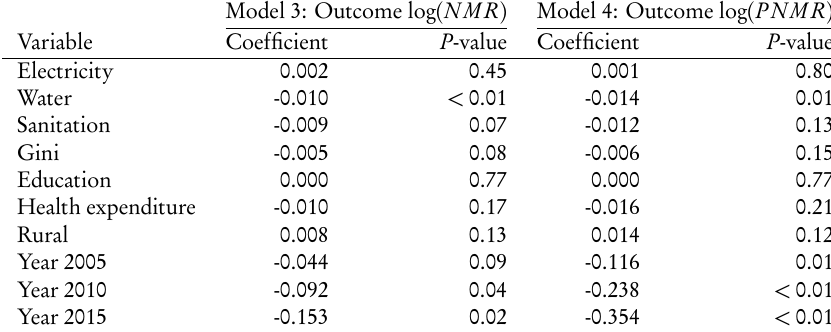
Fixed effect country-level regressions of the log neonatal and post-neonatal mortality rates; Models 3 and